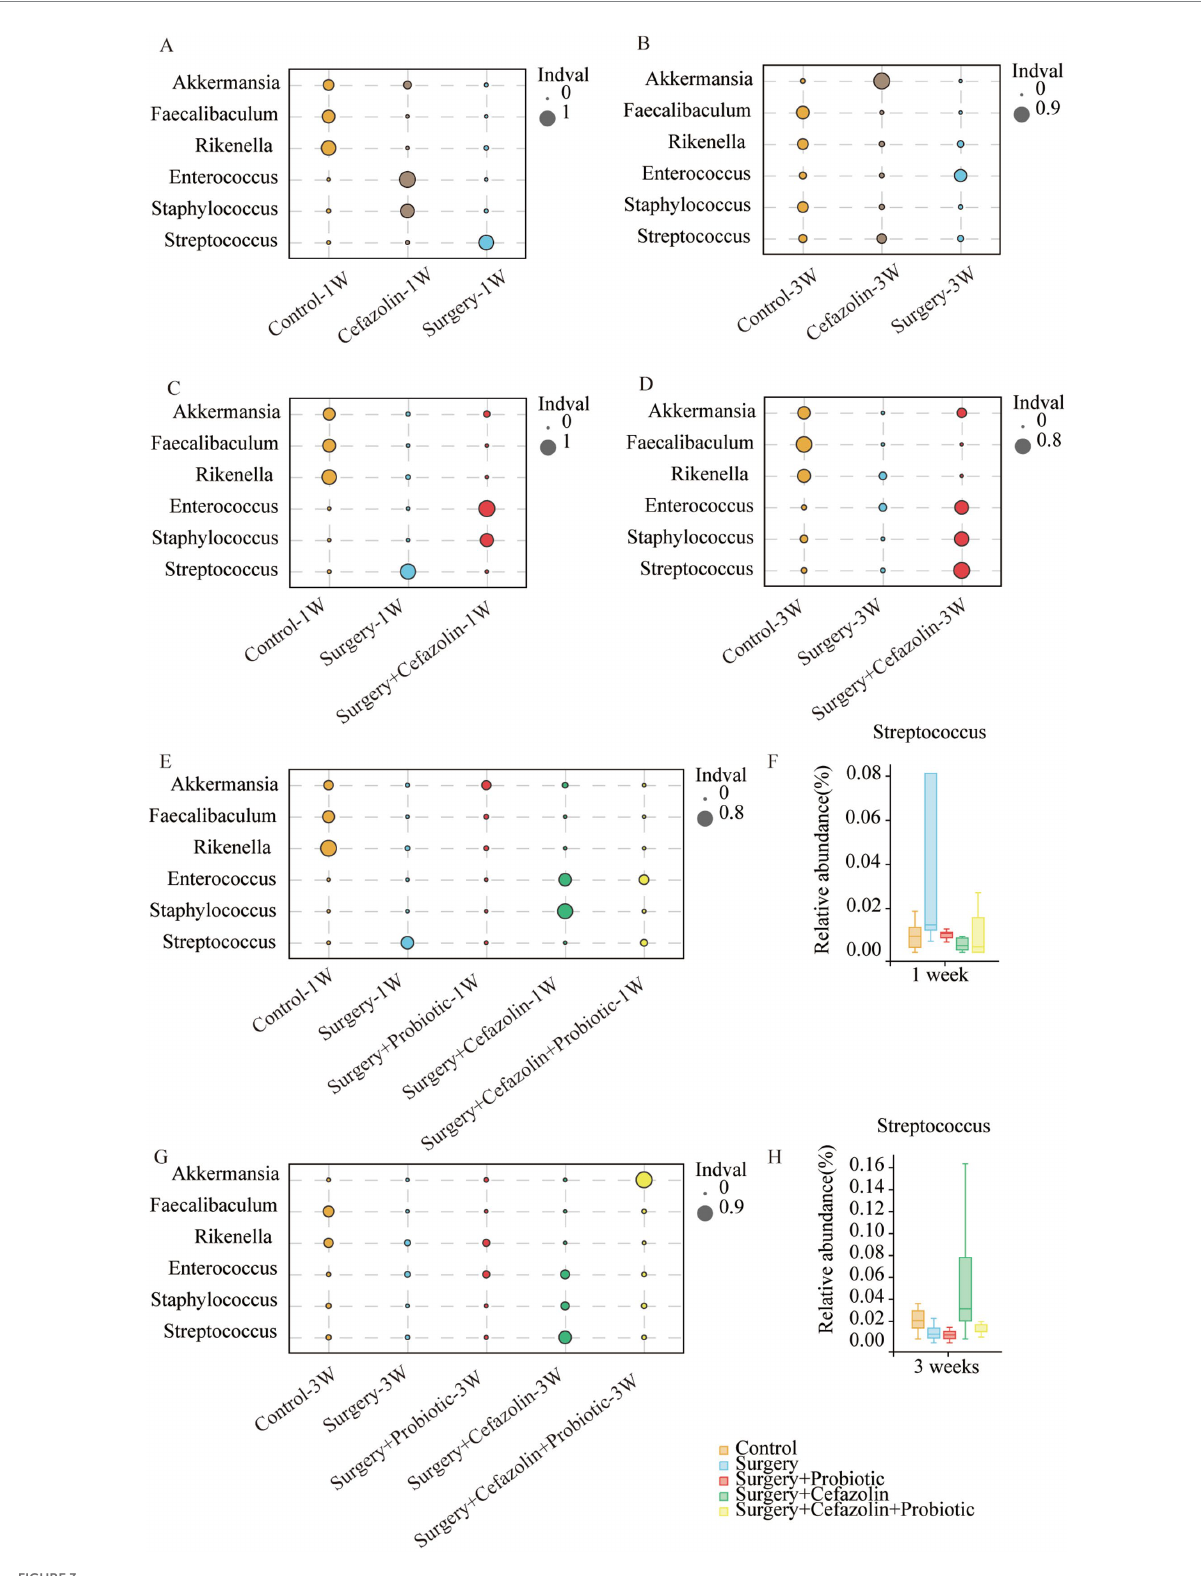
FIGURE 3 The probiotics administration for restoring surgery/anesthesia stress-induced and perioperative cefazolin-induced gut dysbacteria, respectively. (A,B) The differential species analysis in the genus level of Grp CTL, Grp CEF, Grp S at 1 and 3 weeks after surgery; (C,D) The differential species analysis in the genus level of Grp CTL, Grp S, Grp SC at 1 week and 3 weeks after surgery; (E,G) The differential species analysis in the genus level of Grp CTL, Grp S, Grp SP, Grp SC, Grp SCP at 1 and 3 weeks after surgery; (F,H) Surgery/anesthesia stress increased the relative abundance of Streptococcus at 1 week (q = 0.7693, p = 0.0399) while probiotics could decrease it (q = 0.5489, p = 0.0314); cefazolin could increase the relative abundance of Streptococcus at 3 weeks after surgery (q = 0.3125, p = 0.0314) compared with surgery group ( n = 9, Wilcoxon rank sum test). Grp, group; CTL, control; S, surgery; SC, surgery combined with cefazolin; SP, surgery combined with probiotics; SCP, surgery combined with cefazolin and